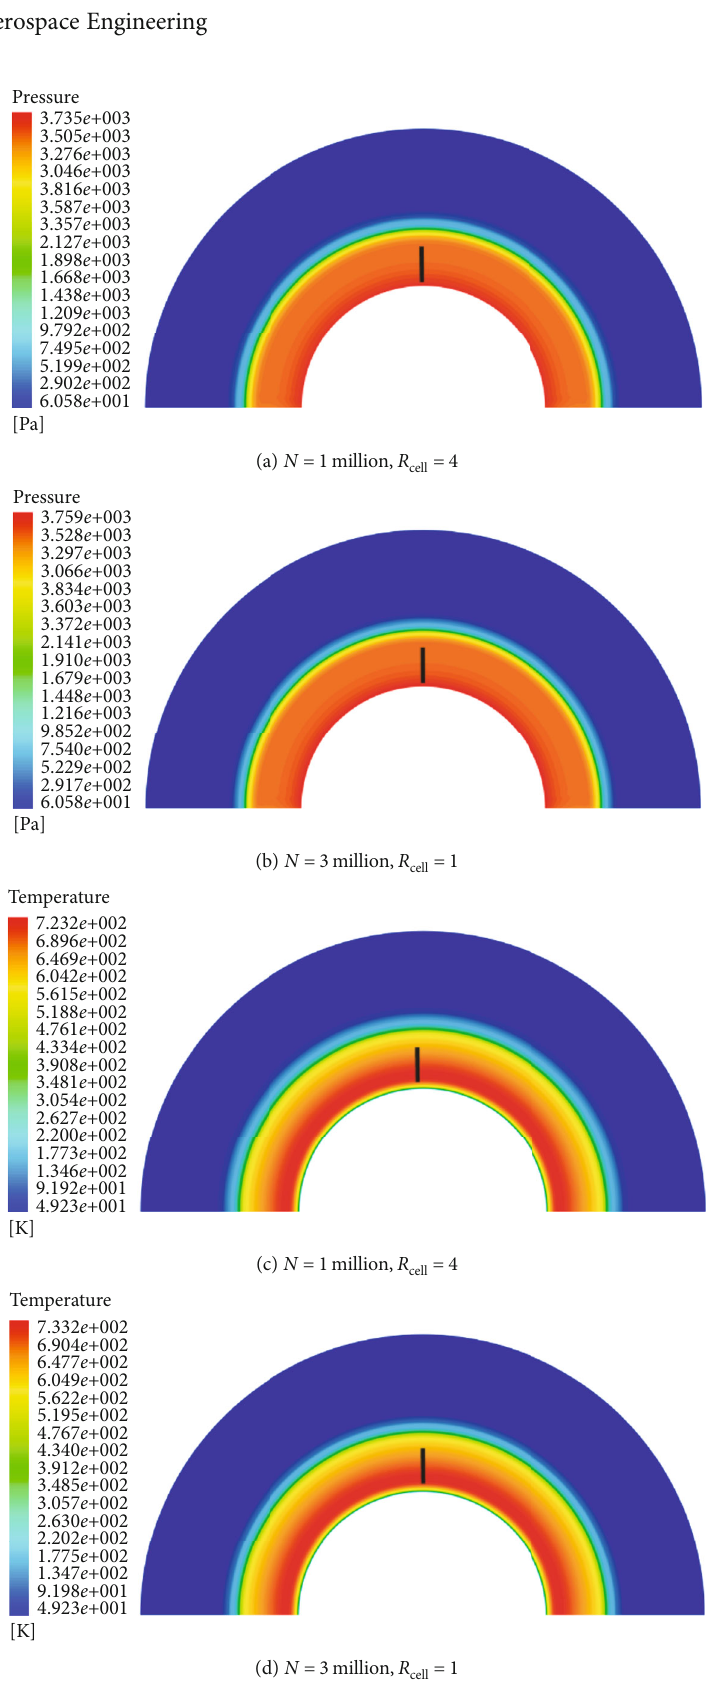
Figure 4: The pressure contour and temperature contour at the plane ( x = 1mm